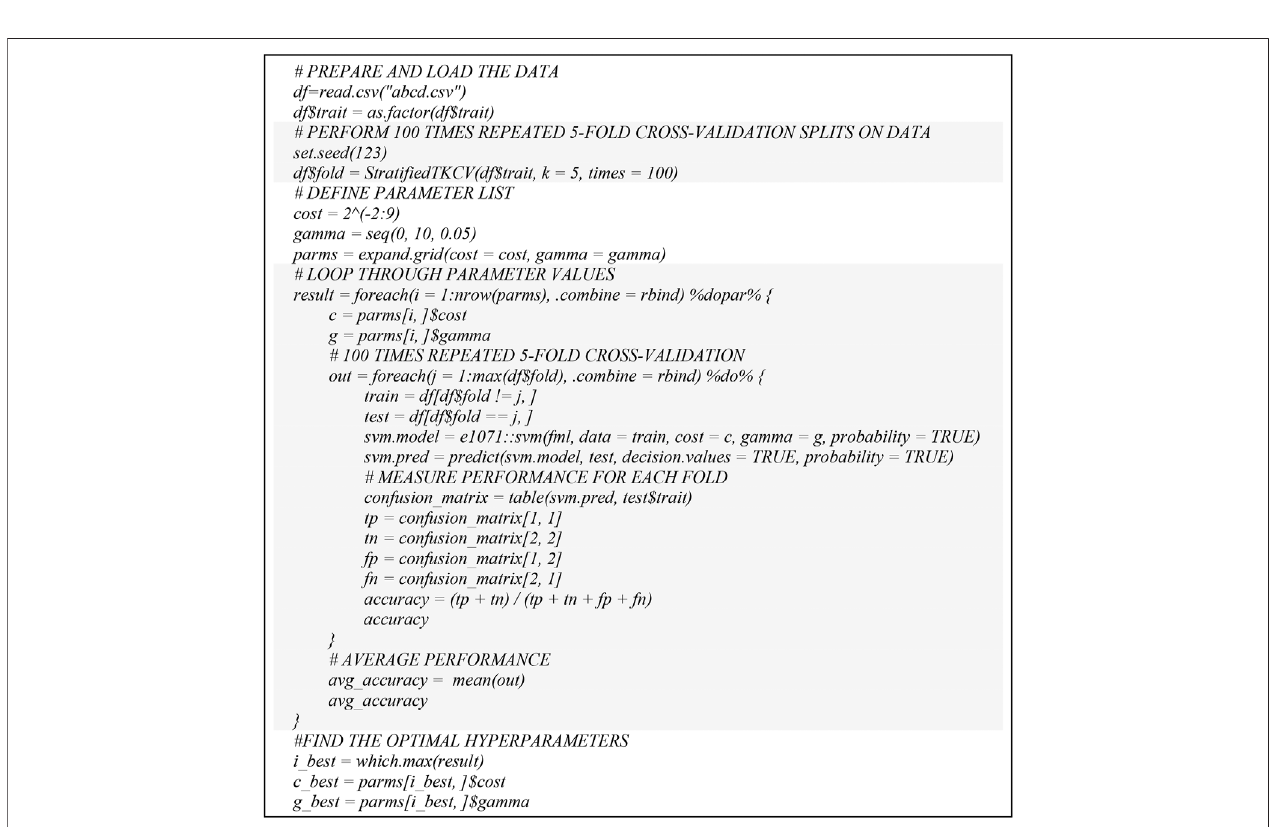
FIGURE 1 | Pseudo code for parallel SVM hyperparameter